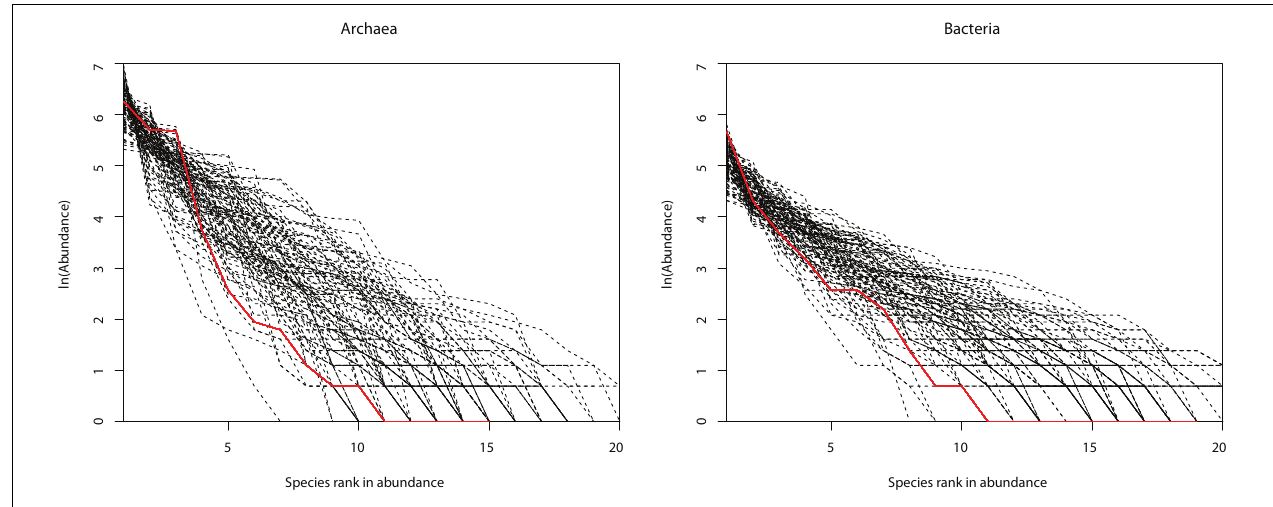
FIGURE 2 | Two examples of the hot-spring microbiome samples that passed the neutrality test: (A) archaea and (B) bacteria. TABLE 2 | Species sorting analysis: the percentage of the influence of pH and/or